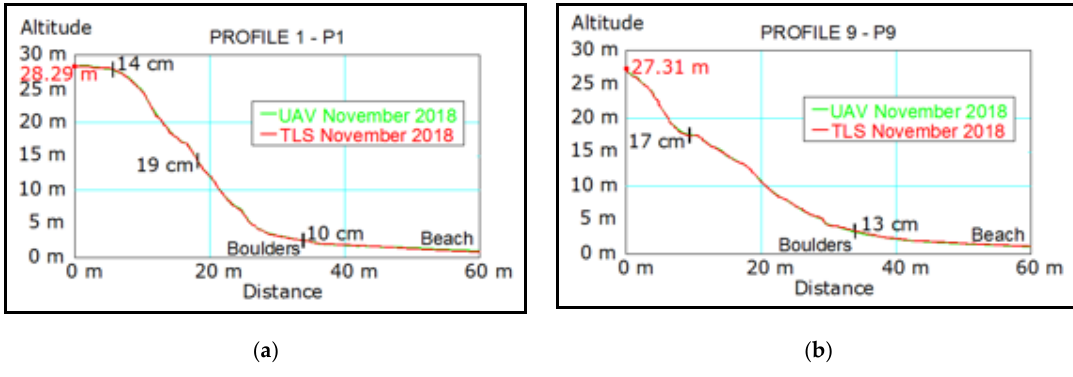
Figure 12. Comparison between the profiles obtained by UAV and by TLS (2018). ( a ) Profile 1 (north area of the cliff); ( b ) Profile 9 (south area of the cliff).